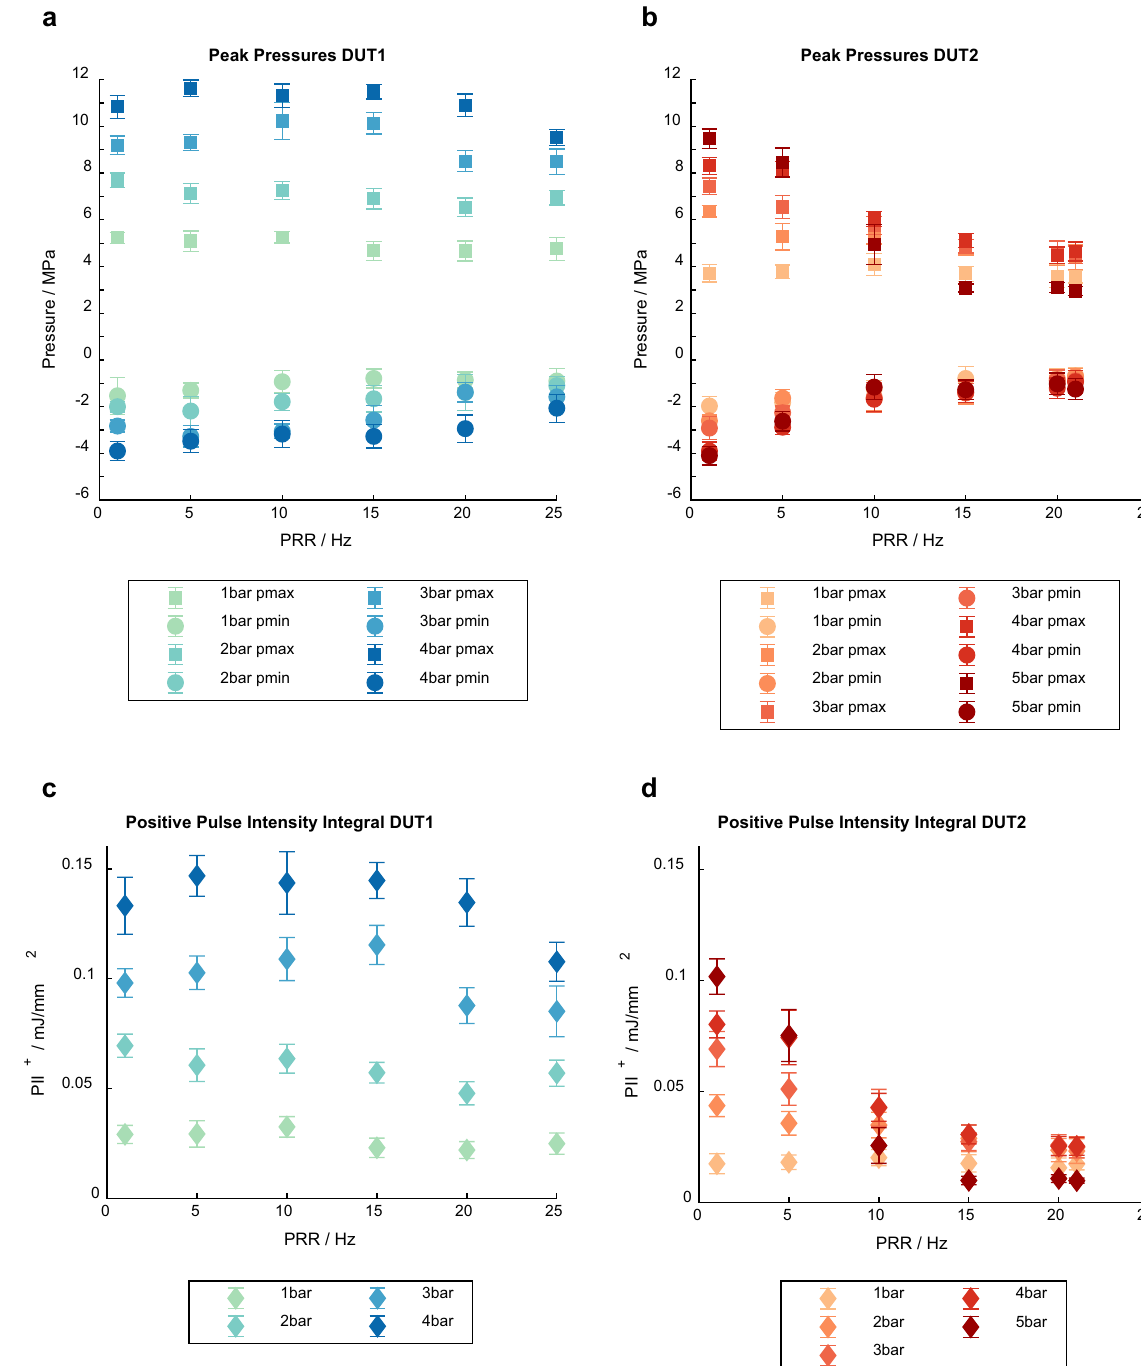
Figure 4. Pressure curve parameters. Measured peak maximum and minimum pressures (p max , p min ) of both devices at different pulse repetition rates and intensity levels ( a , b ); Positive pulse intensity integral (PII + ) of both devices at different pulse repetition rates and intensity levels ( c , d